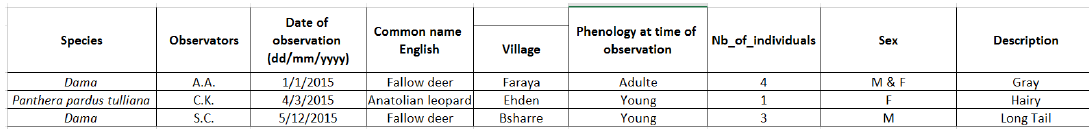
Figure 13. Running